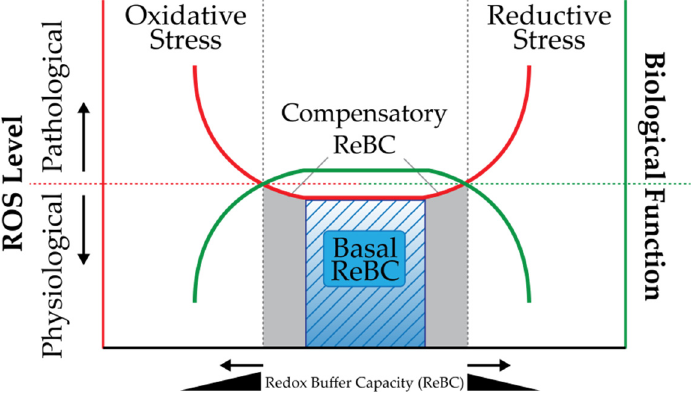
Figure 3. Redox stress. Adapted from [89].